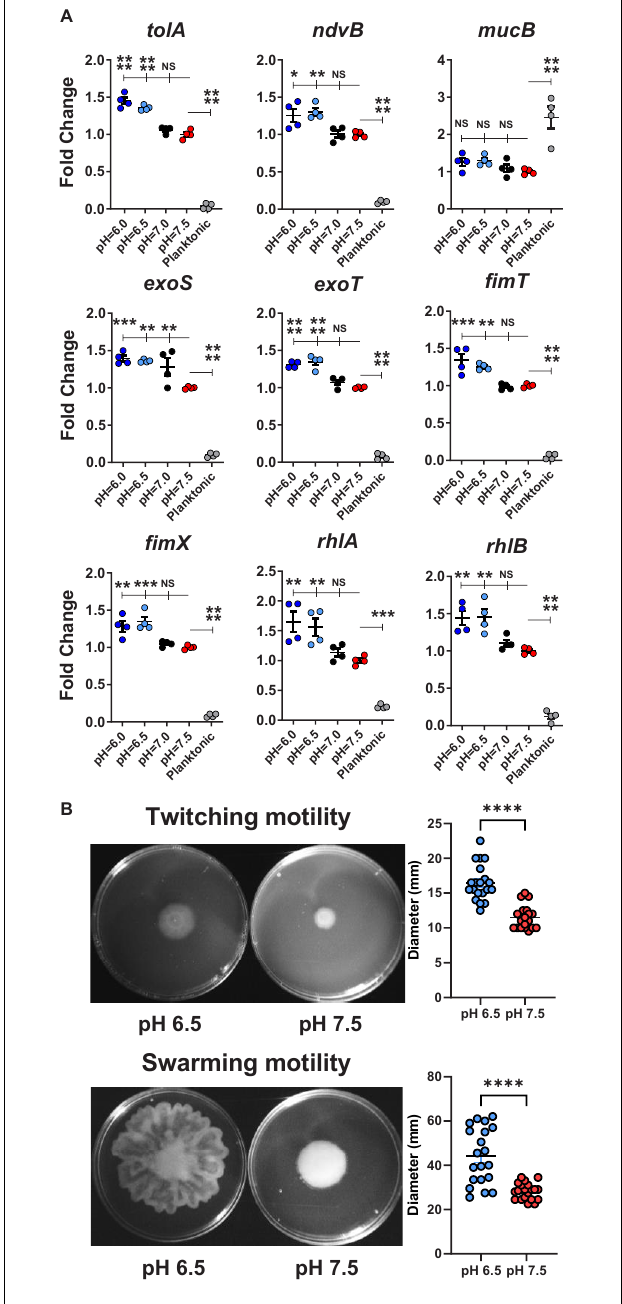
FIGURE 5 | Acidic pH conditions increase biofilm/virulence-related gene expression of P. aeruginosa . (A) P. aeruginosa PAO1 biofilm was cultured in pH adjusted DMEM for 3 h. Physiologically related biofilm condition in pH 7.5 was used as a control for biofilm growth. Planktonic form of P. aeruginosa inoculated in pH 7.5 was also included for comparison ( n = 4). (B) PAO1 motility assays. PAO1 swarming and twitching motility assays were performed on pH adjusted M8 agar ( n = 20). Data were representative of two independent experiments. Results are mean ± SEM. One-way ANOVA and Dunnett’s multiple comparisons test were used for gene expression statistical analysis. Student’s t -tests were used for bacterial motility assay statistical analysis * p < 0.05; ** p < 0.01; *** p < 0.001; **** p < 0.0001; NS, not